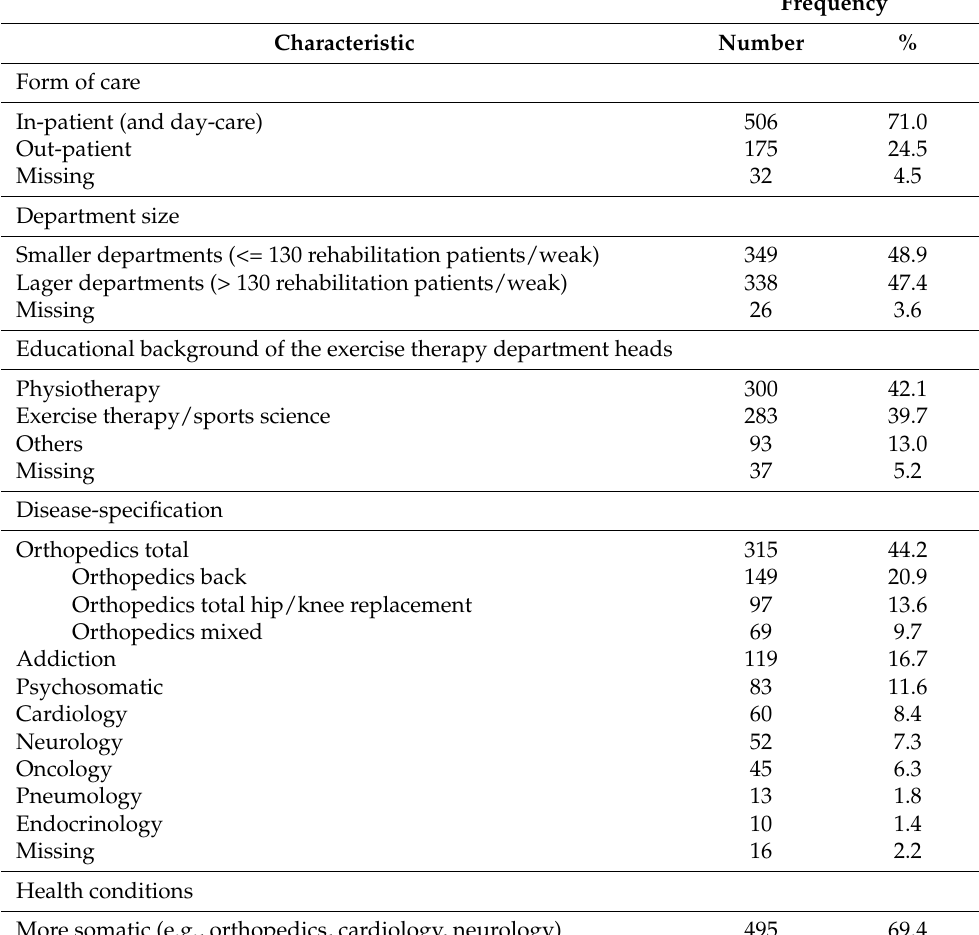
Table 1. Characteristics of the responding exercise therapy departments of the quantitative part of the study (n =